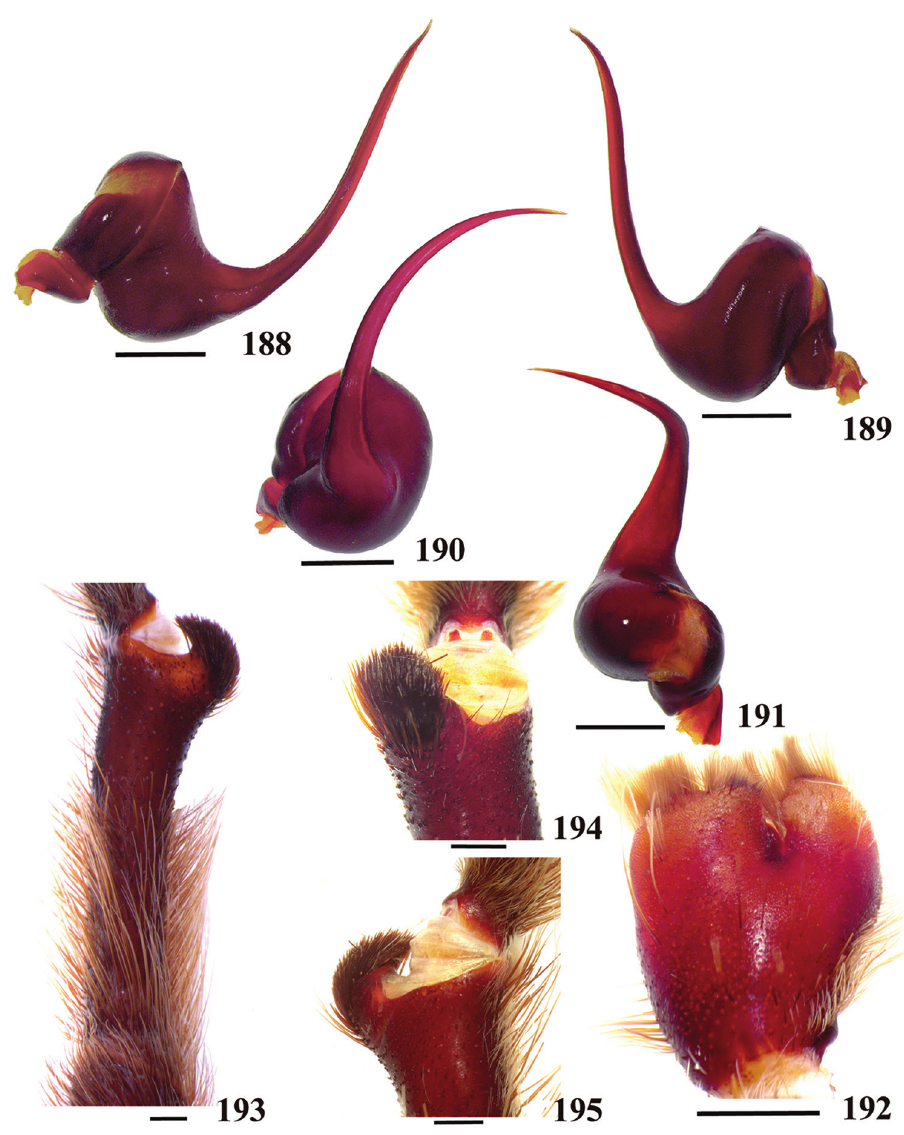
Figures 188–195. Avicularia merianae sp. n., male holotype (AMNH Pe102). 188–191 left palpal bulb 188 prolateral 189 retrolateral 190 frontal 191 dorsal 192 left cymbium, dorsal 193–195 left tibial apophysis of leg I 193 prolateral 194 ventral 195 retrolateral. Scale bars = 1